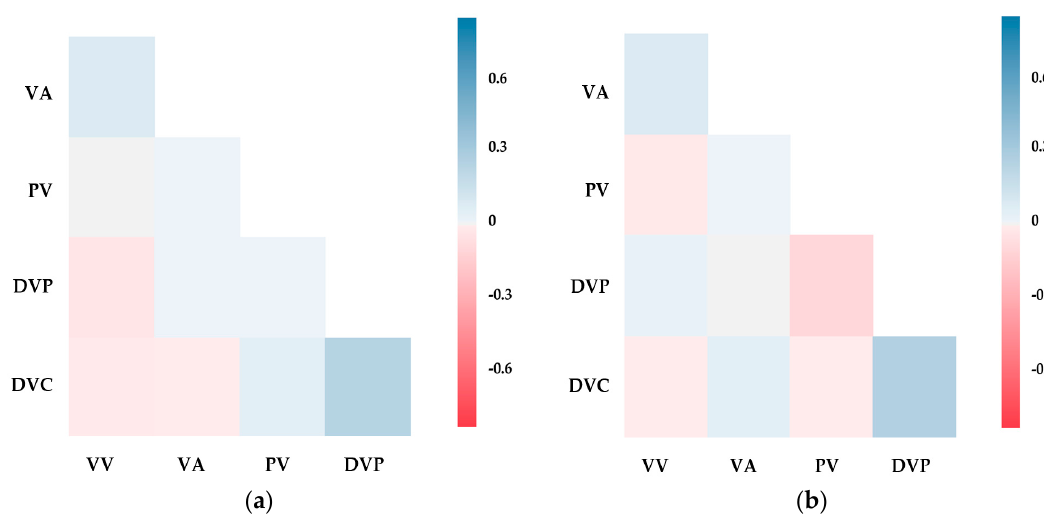
Figure 8. Correlation matrices in ( a ) spot A; and ( b ) spot B.